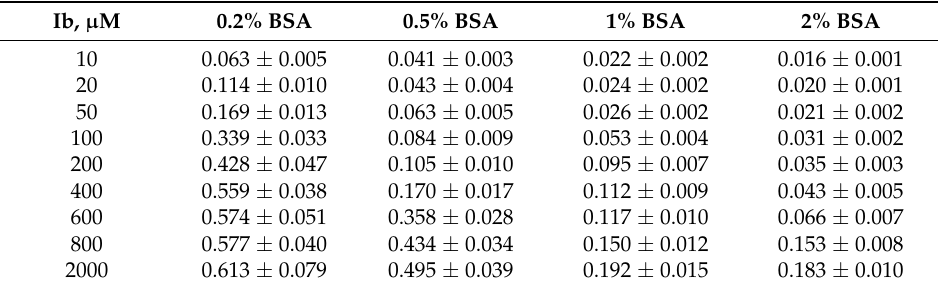
Table 1. The unbound fraction ( f u ) of Ib in the presence of BSA. ( n = 3, mean ± S.D.).